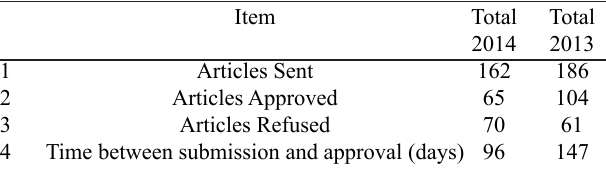
Table 1. Number of manuscripts received, approved and rejected by the Brazilian Journal of Cardiovascular Surgery in 2013 and 2014*